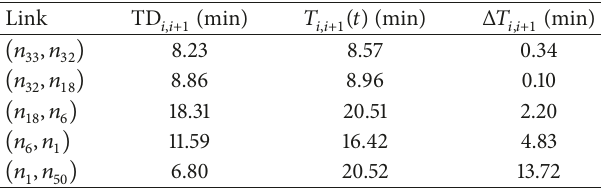
Table 6: The desired travel time and prediction travel